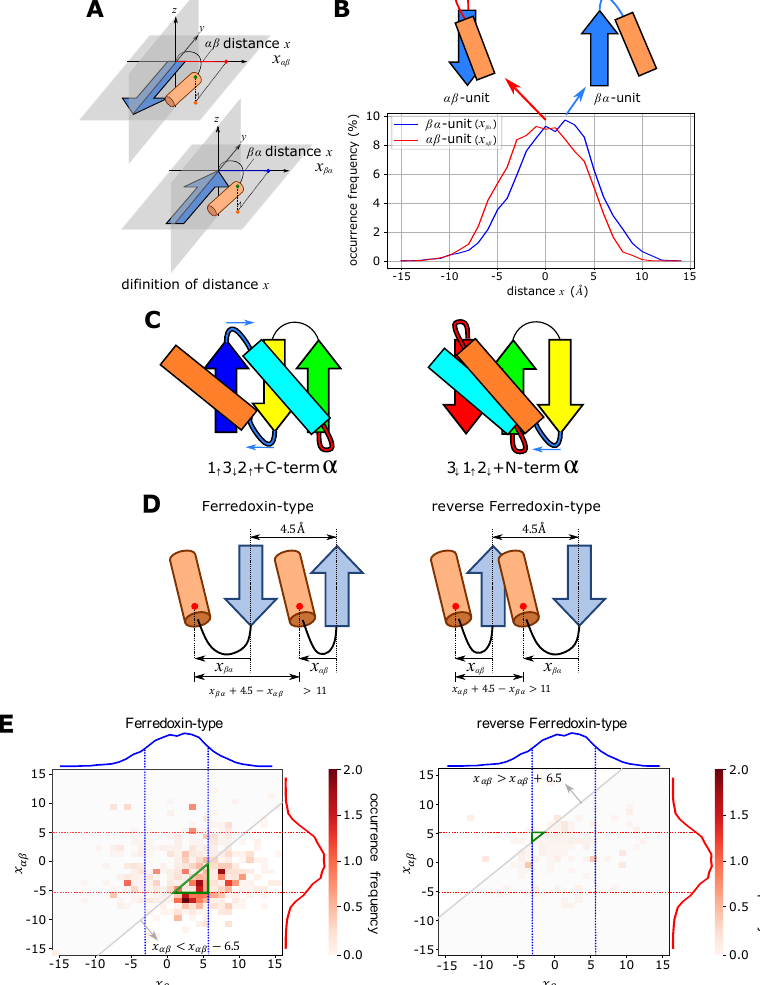
Figure 2. Absence or presence of the structural conflict between α -helices. ( A ) Definition of the distance x between the pleated plane of the β -strand and the α -helix in the αβ -unit (top) and the βα -unit (bottom). ( B ) Distribution of x in the αβ -unit (red) and the βα -unit (blue). The distribution was found in the culled PDB dataset with the parameters of the sequence identity < 30%, the finer resolution than 2.0Å, and the R -factor < 0.25. ( C ) Structural preferences of the the αβ -unit (connected by a red linker) and the βα -unit (connected by a blue linker) prevent collision between the terminal helix and the helix in the βαβ structure in the 1 ↑ 3 ↓ 2 ↑ + C-term α topology (left), while they induce a collision in the 3 ↓ 1 ↑ 2 ↓ + N-term α topology (right). Blue arrows show the shift of α -helix induced by the x > 0 preference of the βα -unit. ( D ) The necessary condition to avoid the collision of two helices. x βα − x αβ + 4.5Å > 11Å for the ferredoxin-type topology and x αβ − x βα + 4.5Å > 11Å for the reverse ferredoxin-type topology. ( E ) The realizable area to avoid the collision and the occurrence frequency of ( x βα , x αβ ) in the ECOD database. The realizable area satisfying the three conditions; the necessary condition to avoid the collision, the condition of the frequency > 5% in the x βα distribution, and the condition of the frequency > 5% in the x αβ distribution; is shown with a green triangle on the ( x βα , x αβ ) plane. The occurrence frequency shown with the gray-scale is superposed. Blue and red curves are distributions in ( B